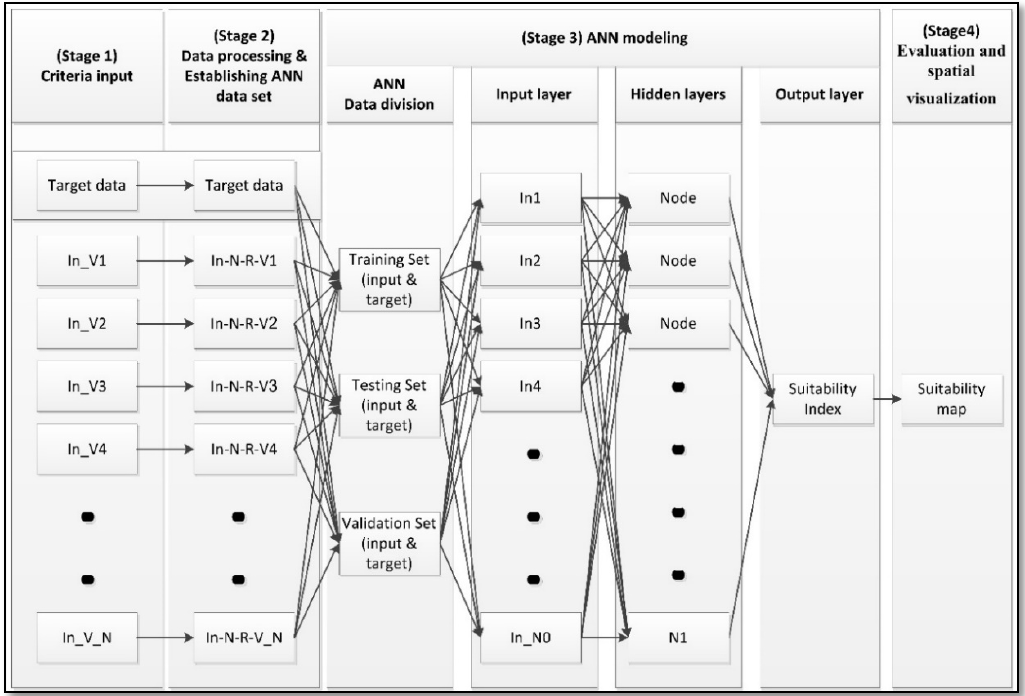
Figure 4. A new framework for implementing ANN in GSS